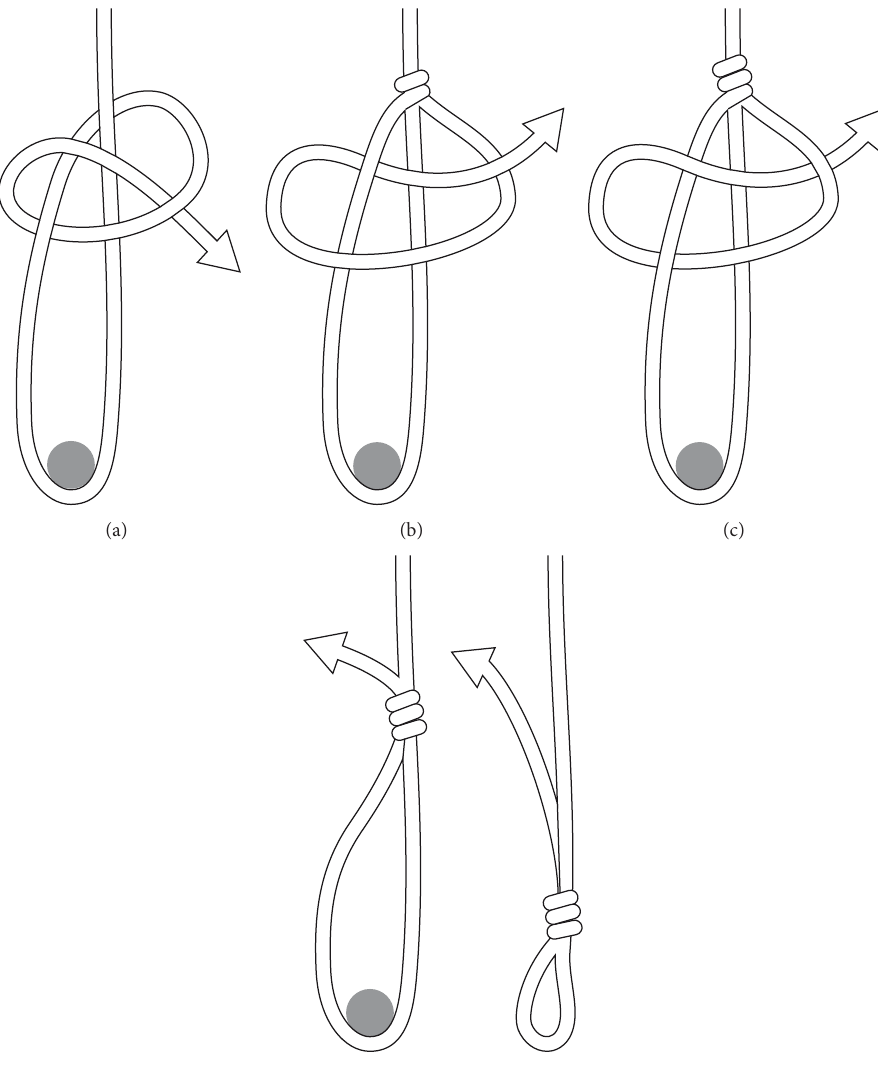
Figure 2: Five-steep diagram showing in a simple way how the adjustable loop is